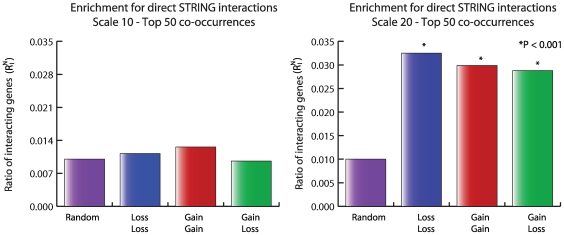
Significance of finding direct interactions in co-occurring genomic loci.For two scales the top 50 co-occurring gene lists for the gain-gain, loss-loss and loss-gain situations were compared to a random set of 100 pairs of genomic loci. For each genomic pair two gene sets were queried for direct interactions using the STRING database. Significance was ascertained using Fisher's exact test on the ratios between all genes and the interacting genes for the co-occurrence gene sets versus the random gene set.